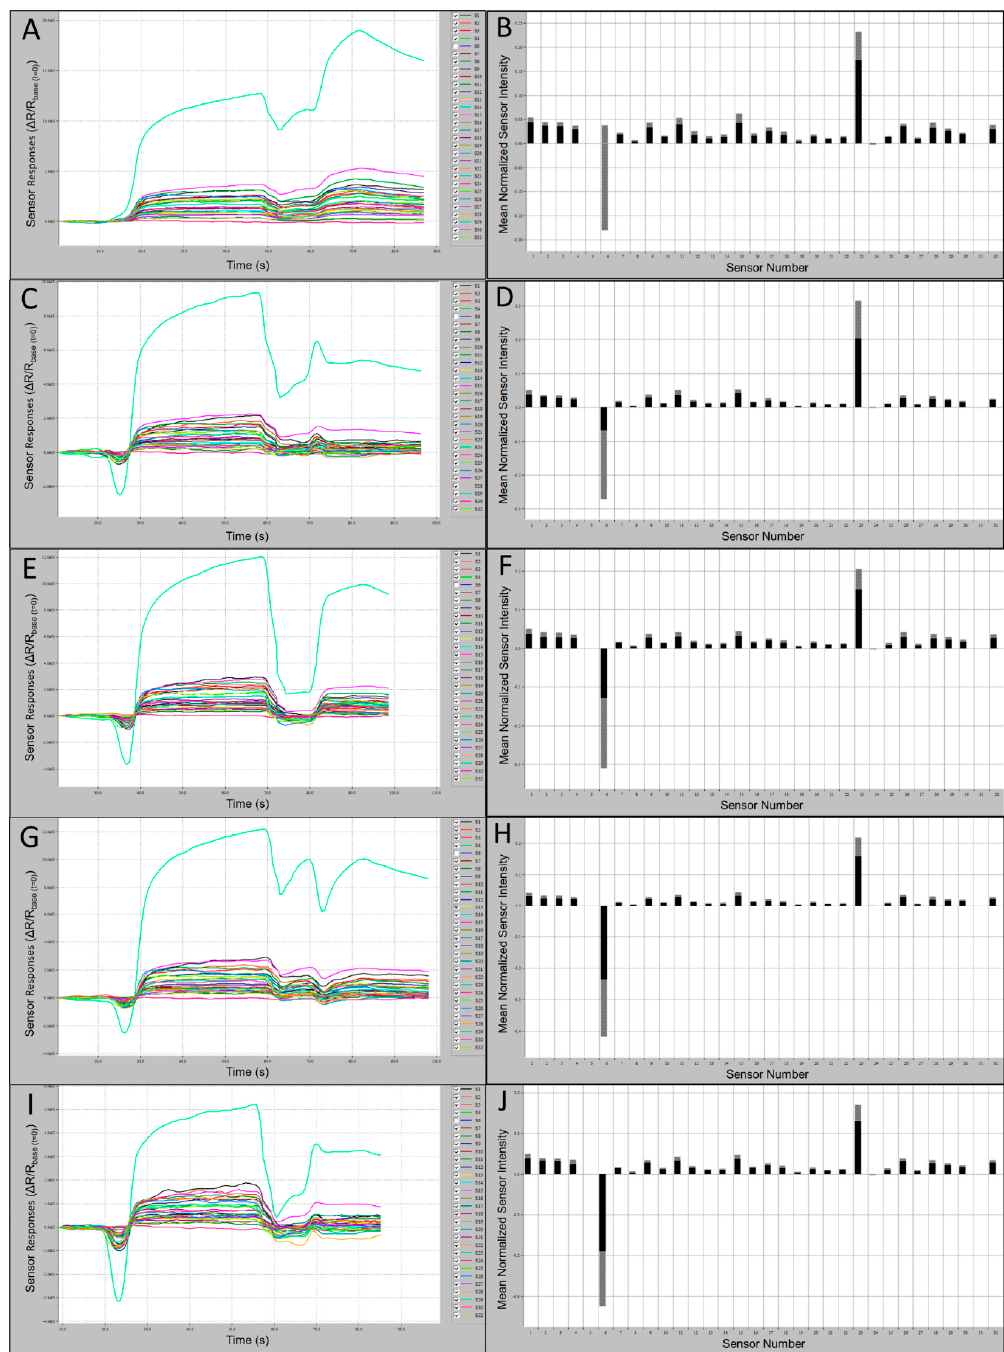
Figure 4. Bat air sample 60 s e ‐ nose analysis runs with 32 ‐ sensor outputs and associated smellprint signatures. ( A ) Sensor ‐ array outputs for Corynorhinus rafinesquii (CORA); ( B ) Smellprint signature of Corynorhinus rafinesquii ; ( C ) Sensor outputs for Lasiurus borealis (LABO); ( D ) Smellprint signature of Lasiurus borealis ; ( E ) Sensor outputs for Lasiurus seminolus (LASE); ( F ) Smellprint signature of Lasiurus seminolus ; ( G ) Sensor outputs for Nycticeius humeralis (NYHU); ( H ) Smellprint signature of Nycticeius humeralis ; ( I ) Sensor outputs for Tadarida brasiliensis (TABR); ( J ) Smellprint signature of Tadarida brasiliensis . Sensor S6 is not displayed. Smellprint bar graphs indicate mean sensor responses in black (±SEM, gray error bar).